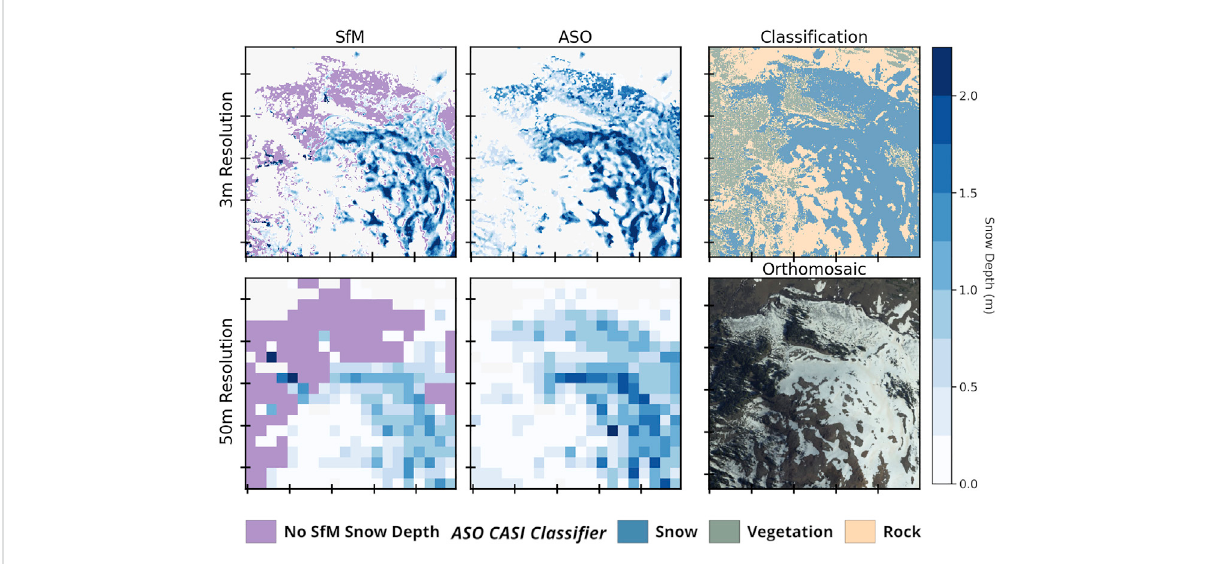
FIGURE 4 Comparison of snow depth between 3 m, and 50 m resolution. SfM did not accurately capture snow depth within vegetated areas but showed goodagreementforopenareasathigheroutputresolution.Thehigher 3 mresolution alsoretrievedmoreareaswithsnow deptharoundvegetation and had closer values of SCA compared to 50 m.